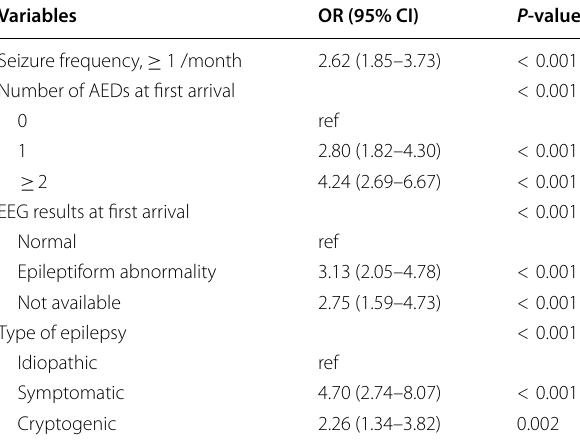
Table 5 Variables found to correlate with drug-resistance in the logistic-regression analysis